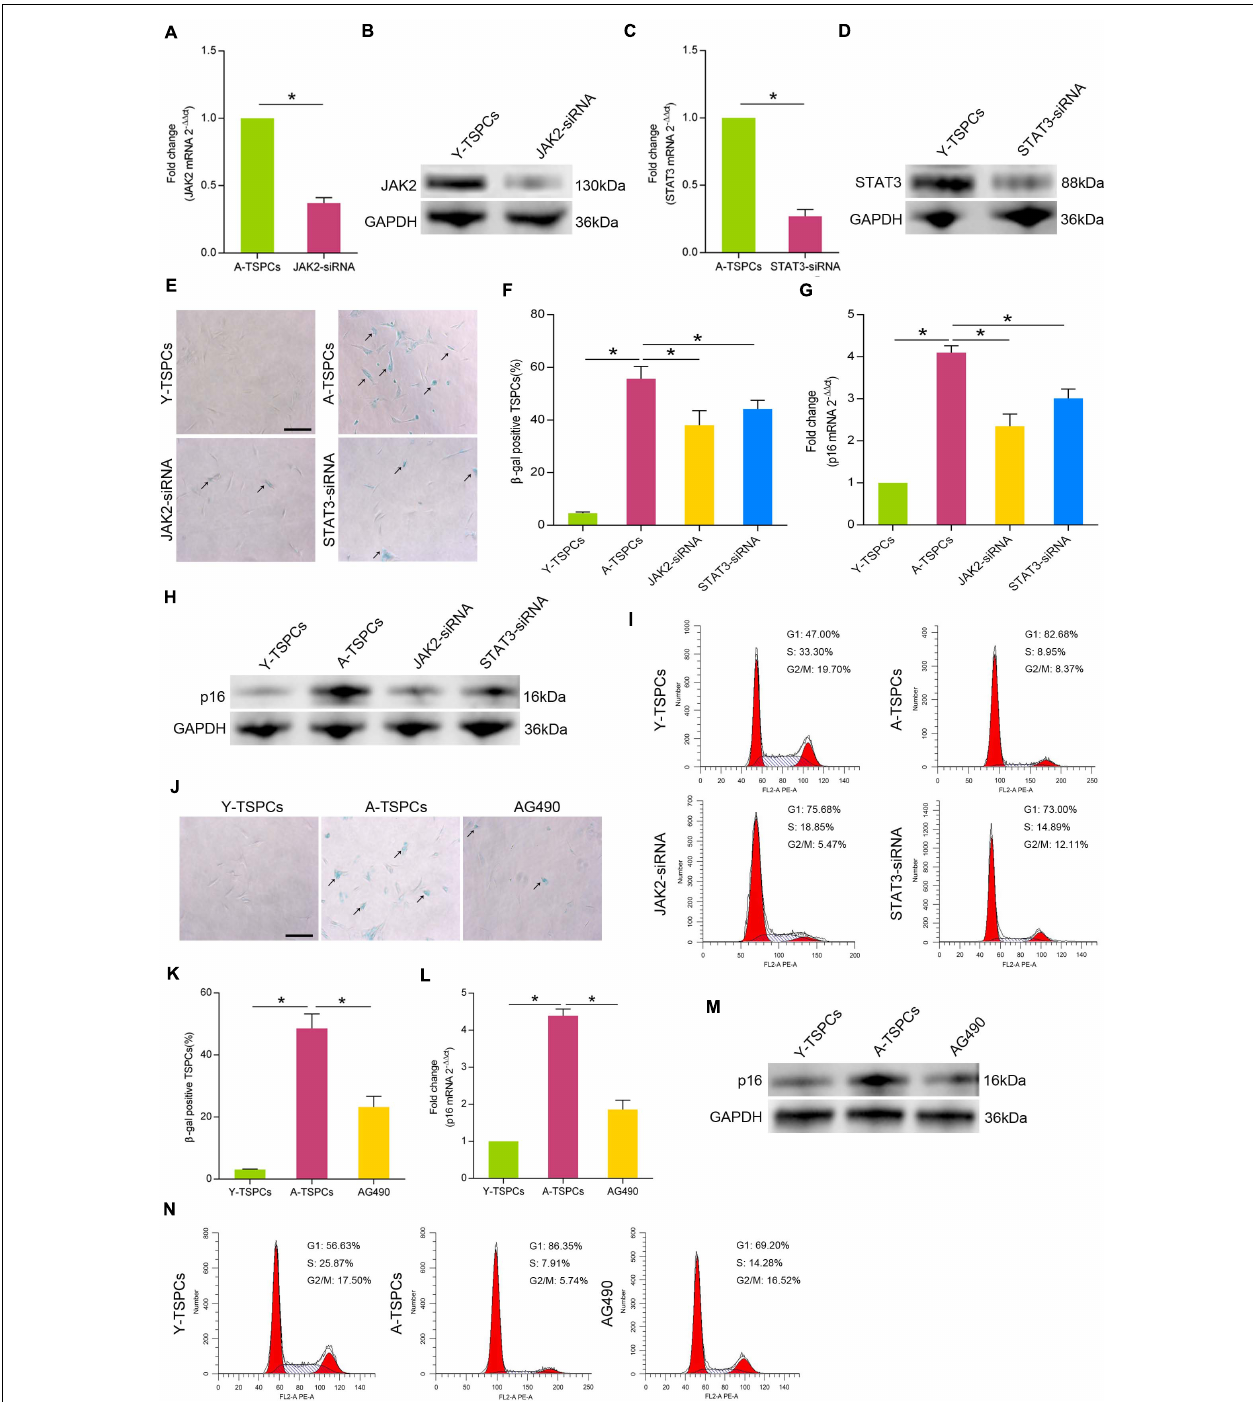
FIGURE 3 | Inhibition of JAK-STAT signaling pathway inhibits cellular senescence. (A , B) The transfection efficiency of JAK2-siRNA was explored by qRT-PCR and Western blotting in aged TSPCs. (C , D) The expression of STAT3 mRNA and protein was measured by qRT-PCR and Western blotting in aged TSPCs after treatment with STAT3-siRNA. (E , F) β -gal staining for the senescent cells in aged TSPCs upon JAK2-siRNA or STAT3-siRNA treatment. Scale bars: 100 µ m. (G , H) The expression of p16 INK4A mRNA and protein was measured by qRT-PCR and Western blotting. (I) The cell cycle distribution of TSPCs was measured by flow cytometry after JAK2-siRNA/STAT3-siRNA treatment. (J , K) β -gal staining for the senescent cells in aged TSPCs after treatment with AG490 treatment (100 µ M, 24 h). Scale bars: 100 µ m. (L , M) The p16 INK4A level was investigated by qRT-PCR and Western blotting in young, aged, and aged AG490-treated TSPCs. (N) Cell cycle analysis of aged TSPCs after AG490 treatment for 48 h. * P < 0.05 compared with the young or aged group.